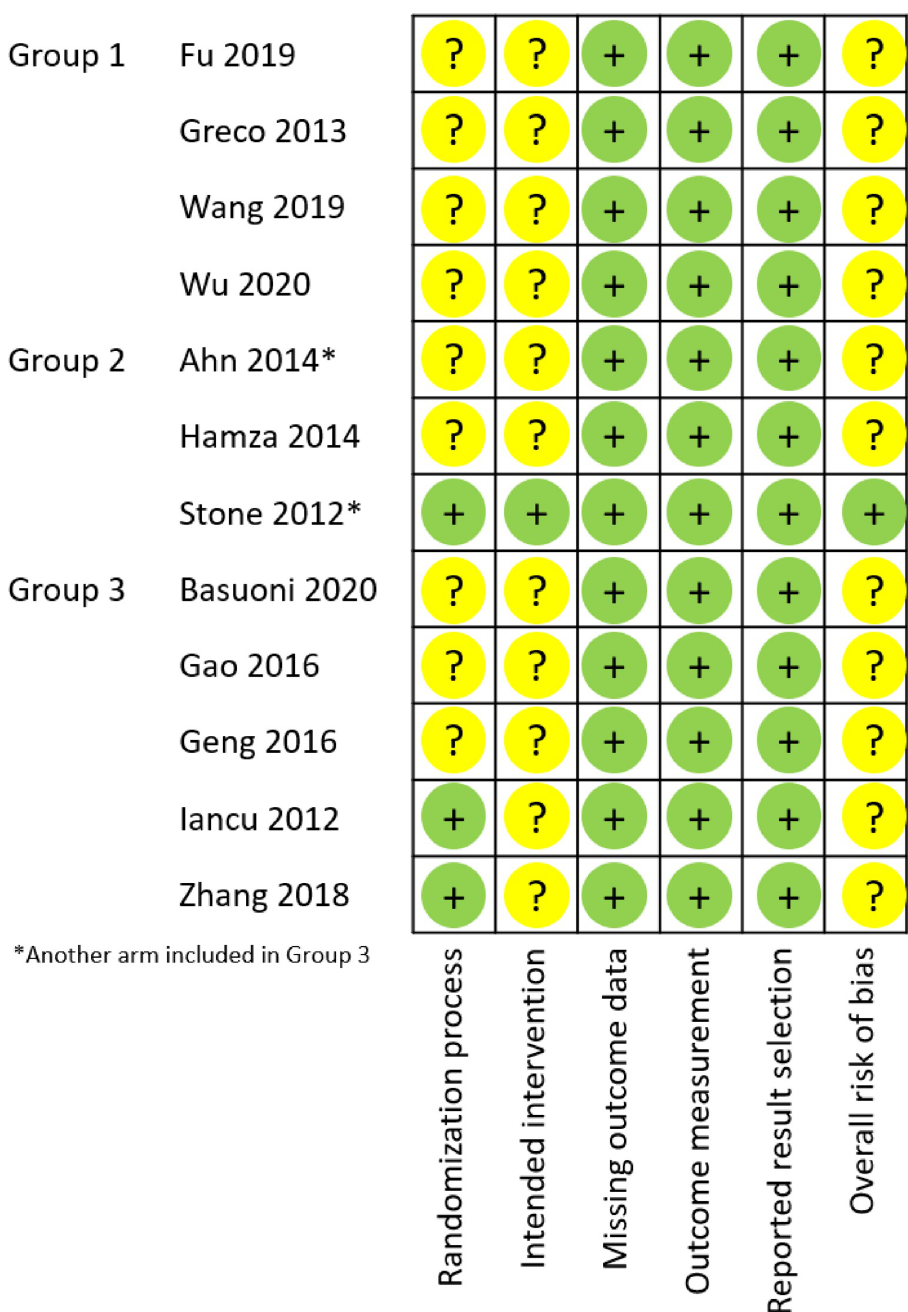
Fig 2. Risk of bias